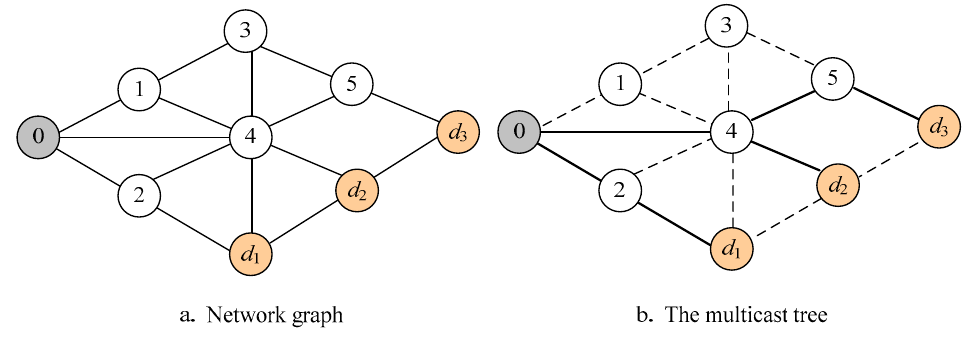
Figure 1. Example of constructing multicast tree.